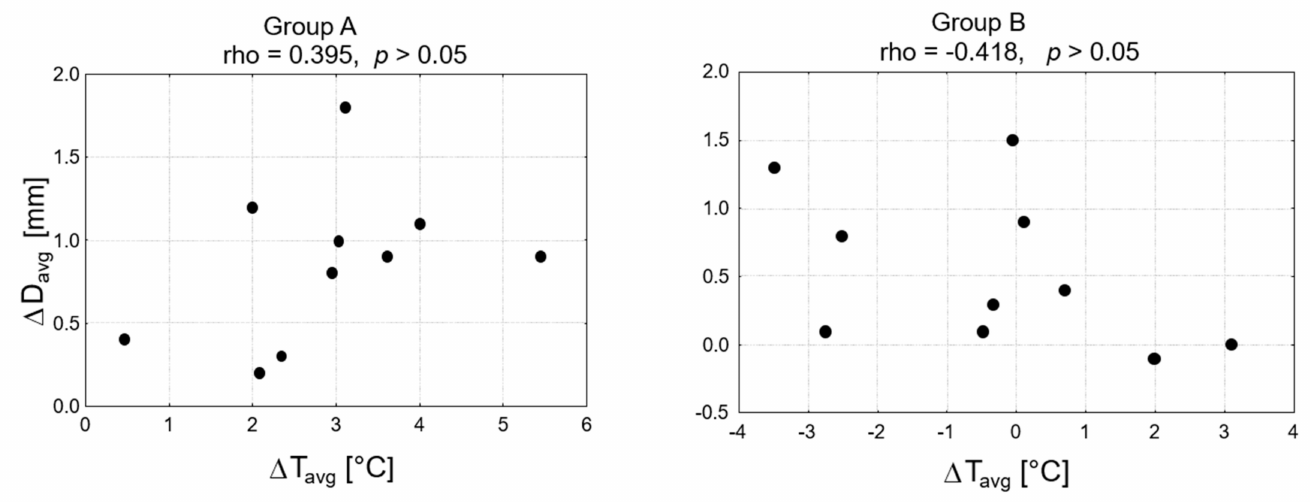
Figure 4. Correlation between the differences in values of skin surface temperature and vein diameter after HILT application in group A and group B, and results of Spearman’s rank correlation coefficient. ∆ T avg , differences in values of skin surface temperature after HILT; ∆ D avg , differences in values of vein diameter after